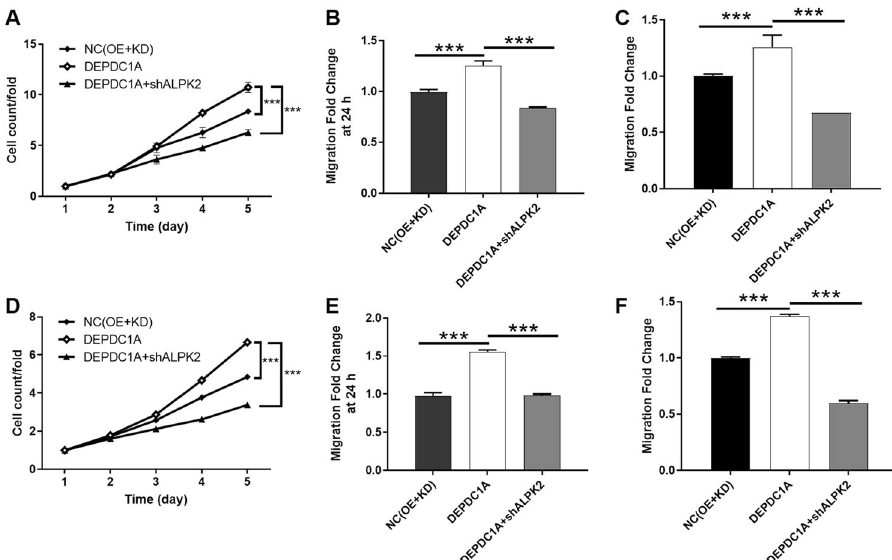
Fig. 6 Overexpression of DEPDC1A attenuated the effects on bladder cancer cells by ALPK2 knockdown. EJ and T24 cell models with mere DEPDC1A overexpression or simultaneous DEPDC1A overexpression and ALPK2 knockdown were subjected to the detection of cell proliferation by Celigo cell counting assay ( A , D ), cell migration by wound-healing assay (B , E ) and cell migration by Transwell assay ( C , F ). Data were shown as mean ± SD. *** P <